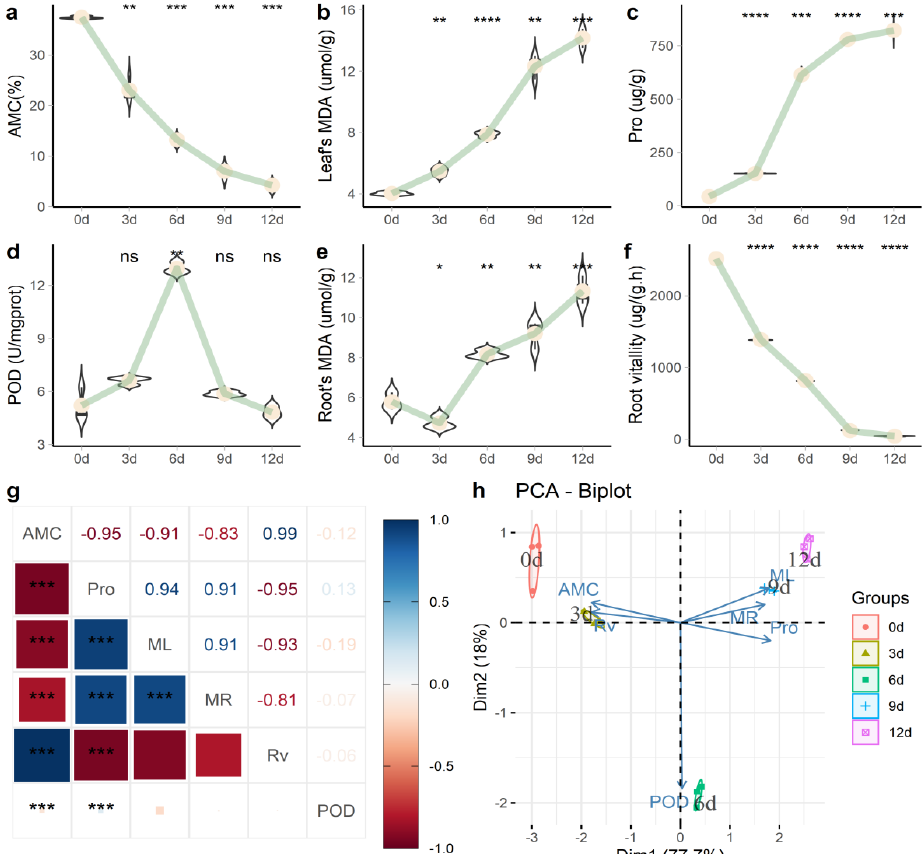
Figure 1. Physiological changes of P. massoniana under persistent drought stress. ( a ) Absolute water content in soil (AMC); ( b ) malondialdehyde (MDA) content in needles; ( c ) needle proline (Pro) content; ( d ) needle peroxidase (POD) activity; ( e ) MDA content in roots; ( f ) root activity; ( g ) correlation analysis of various biochemical indicators; ( h ) PCA analysis. Note: In Figure 1a–f, we used the “0 d” group as a reference to compare the mean and added p -value and significance markers (“*” indicates that there is a difference compared with the “0 d” group; * p < 0.05, ** p < 0.01, *** p < 0.001, **** p ≤ 0.0001 and “ns” means no difference). In Figure 1g, the number represents the magnitude of the correlation, and the color represents the positive and negative correlations.